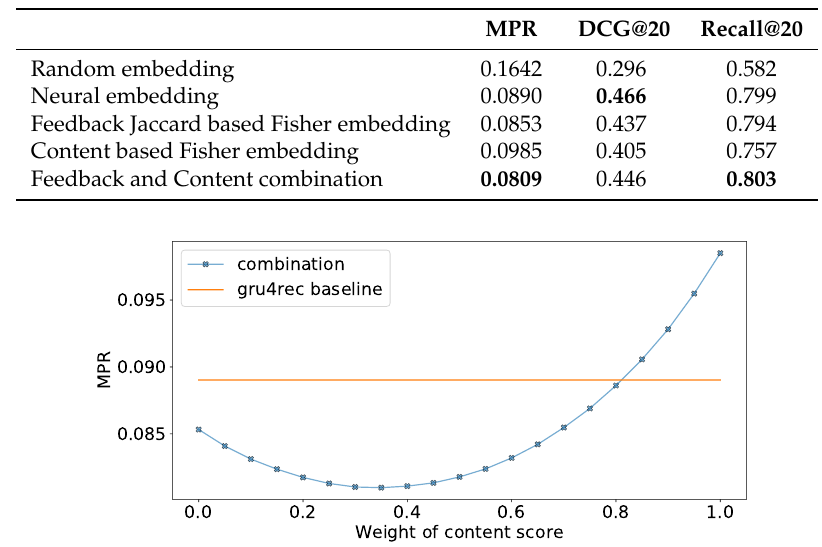
Figure 8. Linear combination weights for Feedback Jaccard and content based Fisher embedding models.